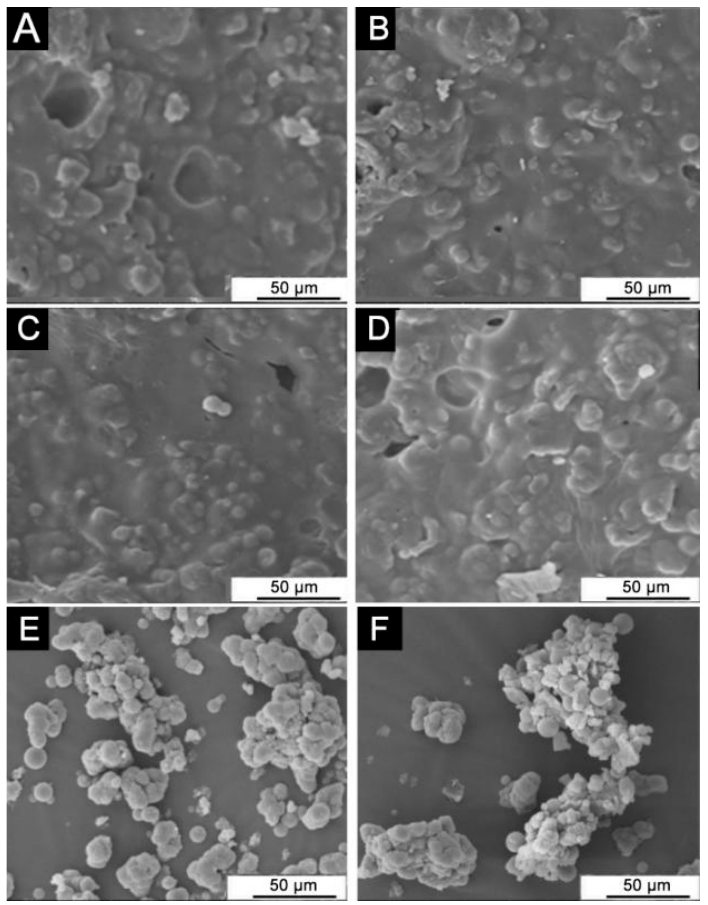
Figure 4. SEM of coating: ( A ) PS0TD20, ( B ) PS5TD20, ( C ) PS15TD20, and ( D ) PS25TD20. SEM of ( E ) shellac microcapsules and ( F ) discoloration microcapsules.